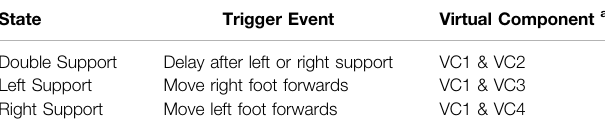
TABLE 2 | Transitions of Walking State Machine. State Trigger Event Virtual Component